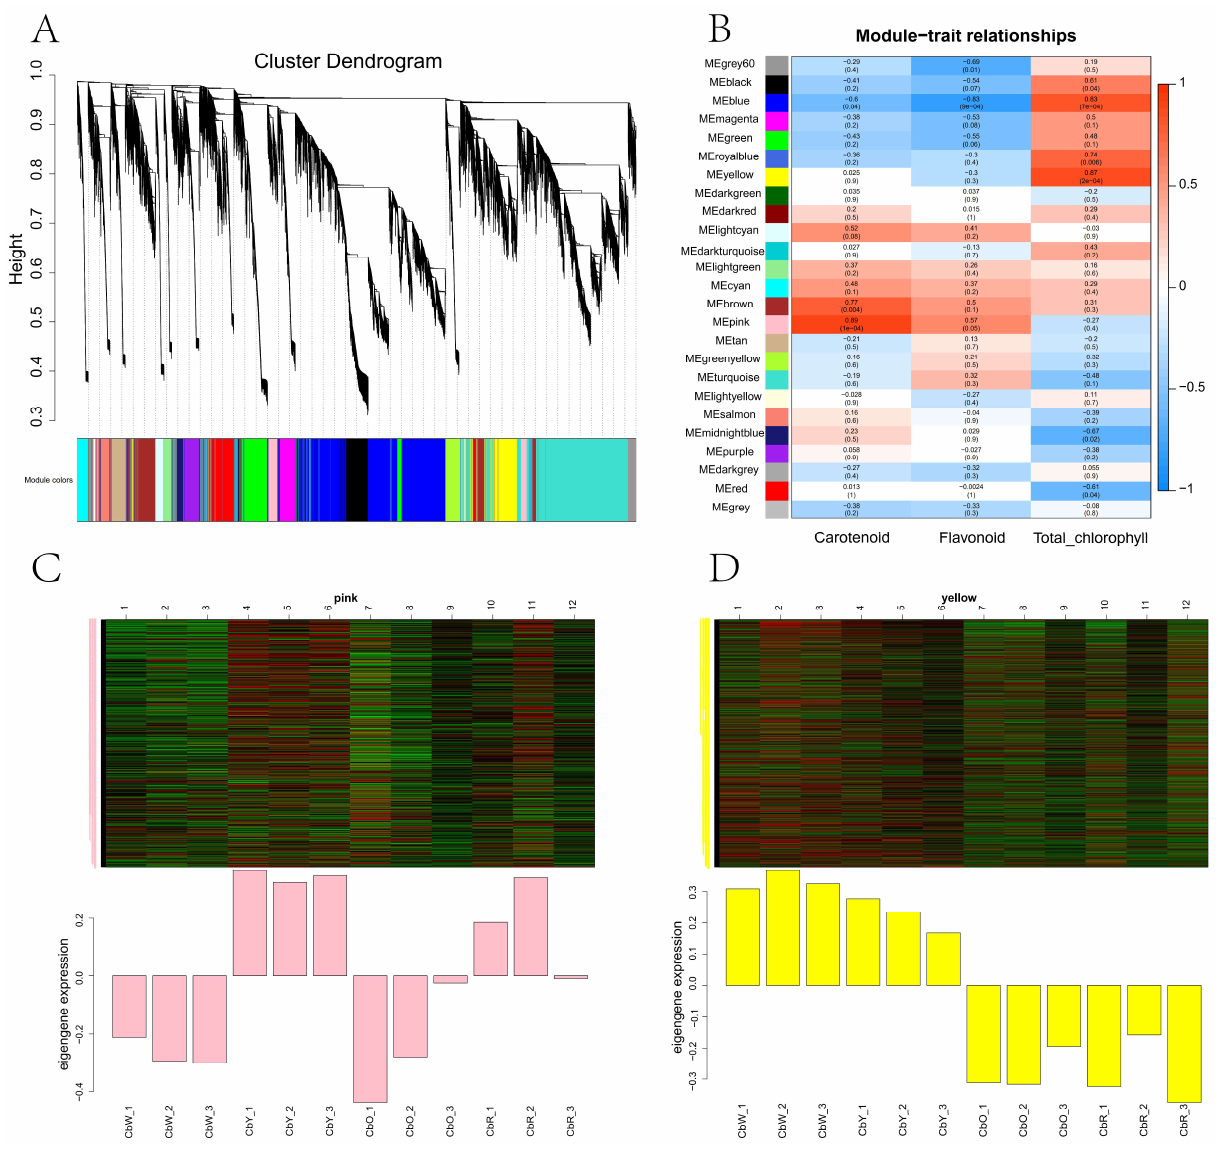
Figure 5. ( A ) Module hierarchy clustering tree diagram. ( B ) Heat map of correlations between modules. ( C , D ) Heat map of correlations between sample traits and modules, ( C ) is the pink module and ( D ) is the yellow module. The horizontal coordinate is the sample, the vertical coordinate is the module, the number in each grid represents the correlation between the module and the sample, the closer the value is to 1, the stronger the positive correlation between the module and the sample; the closer it is to −1, the stronger the negative correlation between the module and the sample. The number in parentheses represents the significance Pvalue, the smaller this value is, the stronger the significance is. def: the amount of gene expression within the module.